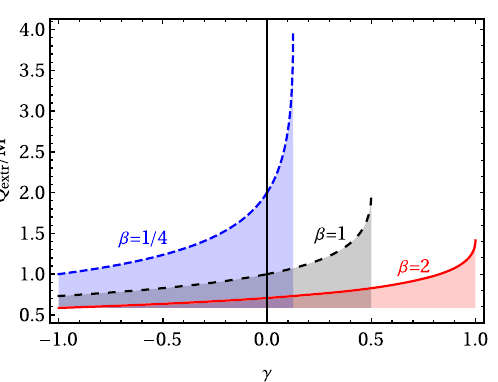
Fig. 1 The radius of the event horizon as a function of γ parameter for the different values of β